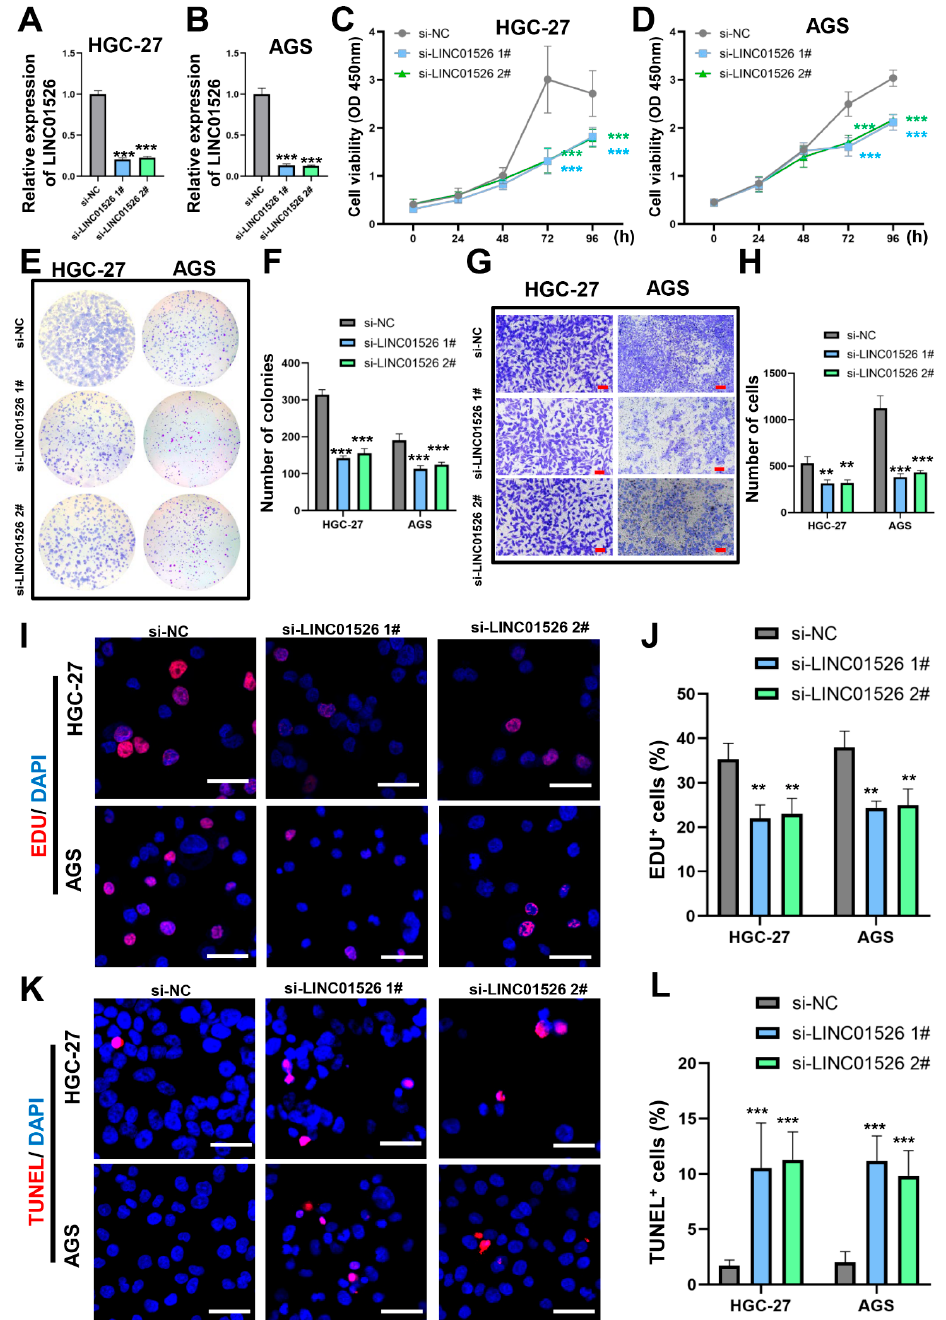
Figure 2. The effect of LINC01526 on GC cell proliferation, migration, and apoptosis in vitro. ( A , B ) Relative LINC01526 expression levels in ( A ) HGC-27 and ( B ) AGS cells transfected with si-NC or si-LINC01526 #1 or #2, assessed by RT-PCR; n = 3 in each group. ( C , D ) CCK8 assay ( n = 6) results showing the viability of cells transfected with si-LINC01526. ( E ) Colony formation ability in cells transfected with si-LINC01526; n = 3 in each group. ( F ) Quantification of results from ( E ). ( G ) Transwell assays ( n = 3) results showing cell migration ability; scale bars: 50 µ m. ( H ) Quan- tification of results from ( G ). ( I ) EdU assay ( n = 3) results showing cell proliferation; proliferating cells were labeled with EdU (red), and cell nuclei were stained with DAPI (blue); scale bars: 50 µ m. ( J ) Quantification of results from ( I ). ( K ) TUNEL assay ( n = 3) results showing apoptosis; apoptotic cells were labeled with TUNEL (red), and cell nuclei were stained with DAPI (blue); scale bars: 50 µ m. ( L ) Quantification of results from ( K ). ** p < 0.01, and *** p <